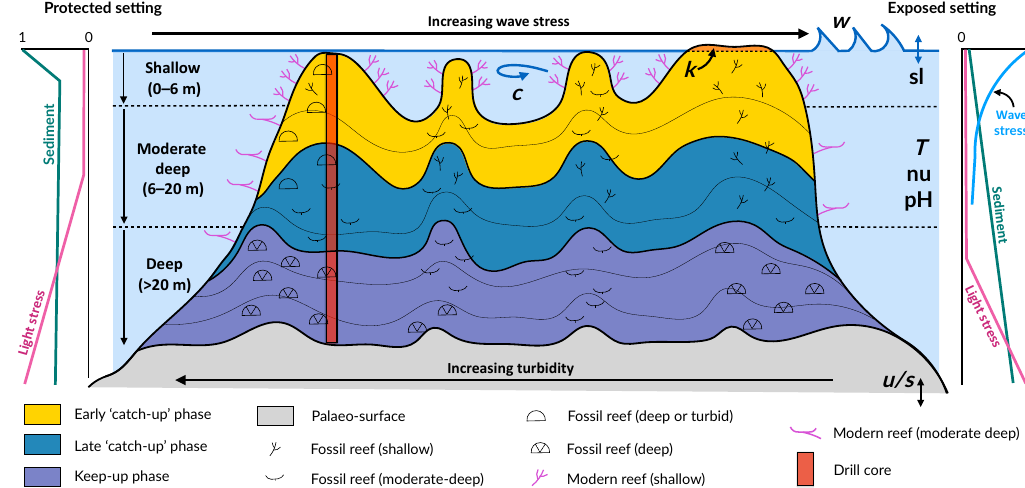
Figure 1. Schematic figure of a hypothetical reef with transitions from deep to shallow reef assemblages occurring up-core, illustrating a catch-up reef growth response to environmental forcing including light, sea-level changes (sl), hydrodynamic energy ( w : wave conditions; c : currents), tectonics ( u : uplift; s : subsidence), oceanic conditions ( T : temperature; nu: nutrients; pH: acidification), karstification ( k ) and sediment